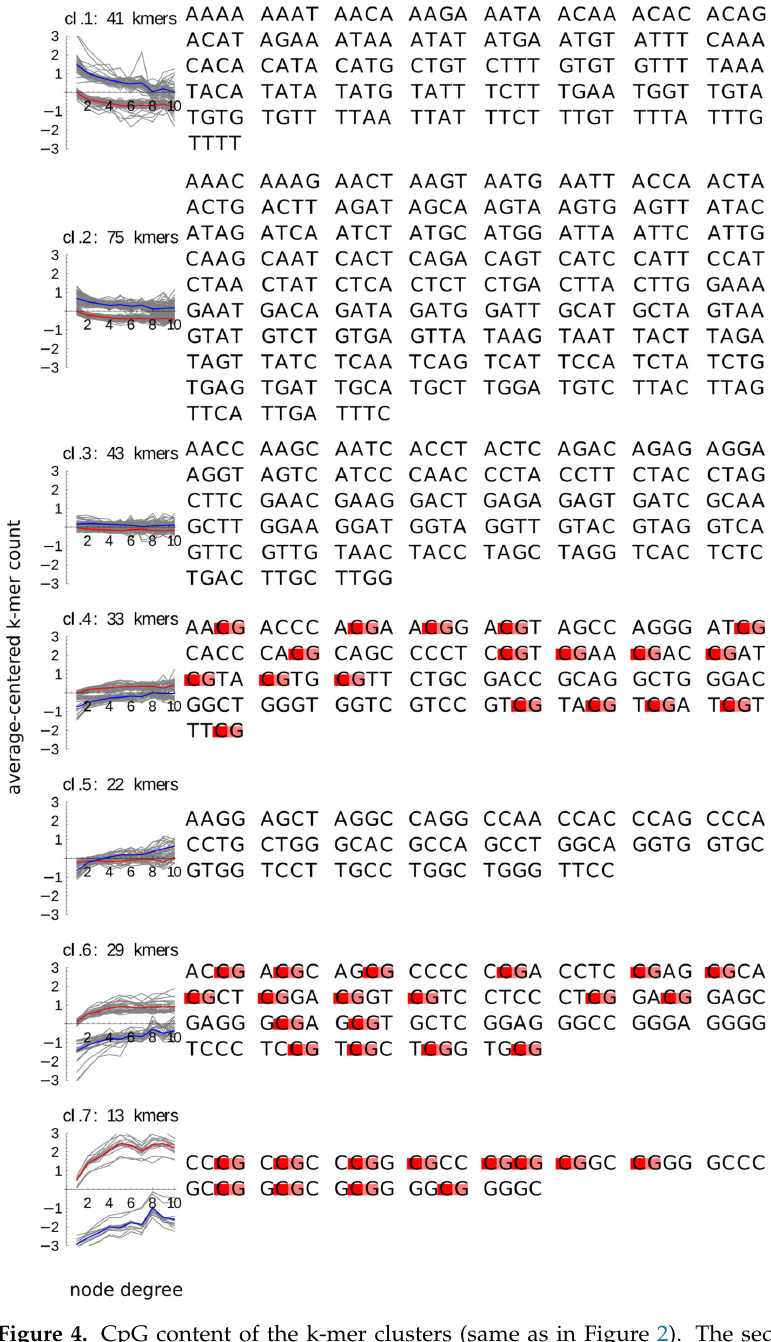
Figure 4. CpG content of the k-mer clusters (same as in Figure 2). The sequences of k-mers in each cluster are plotted alongside the profiles of this cluster, with CpG dinucleotides (in the 5 ′ -3 ′ orientation) marked by colors: G-pink, C-red. 2.3. Promoters Are More Similar to Their Interacting Enhancers than Vice-Versa